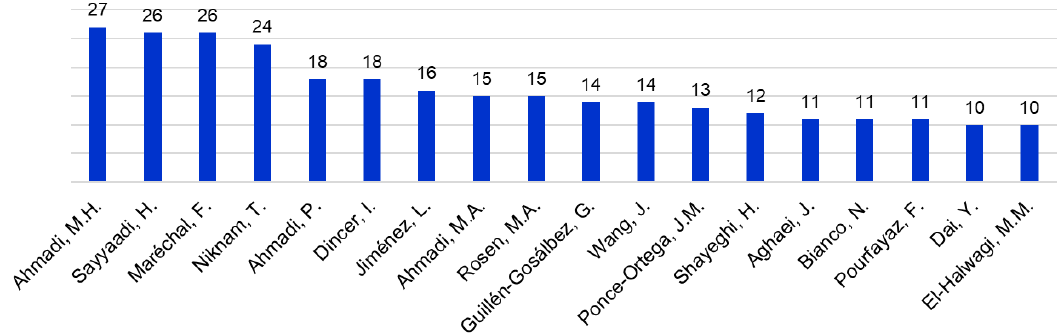
Figure 6. Researchers who (co-)authored 10 or more journal papers/reviews in Figure 5.